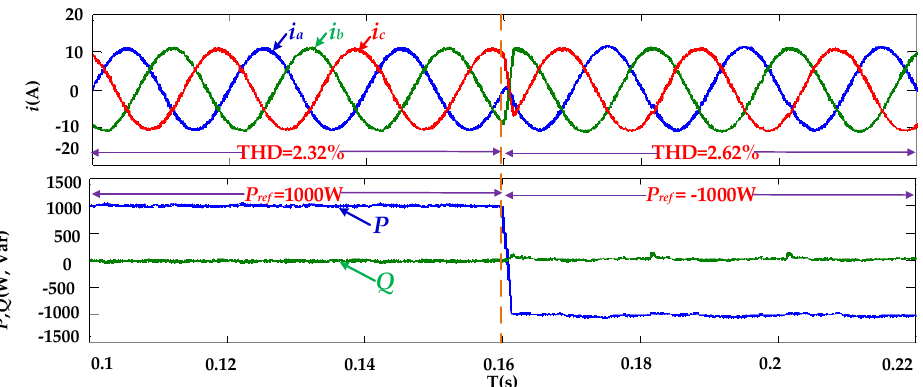
Figure 9. Dynamic simulation results of transition between inverter and rectifier mode with the proposed CF-MPDPC for a TPFS converter.